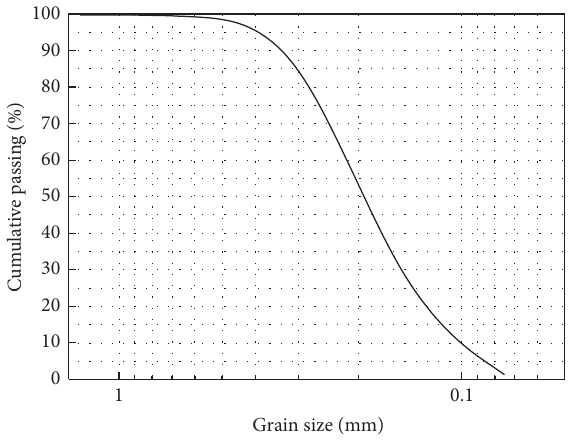
Figure 2: Grain size distribution of the studies dune